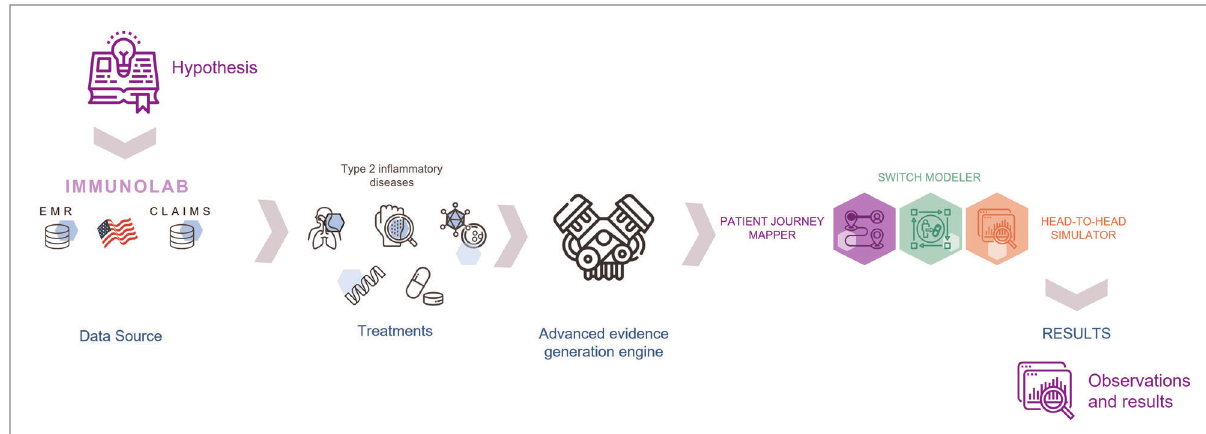
FIGURE 1 Schematic fi gure with the different components of the